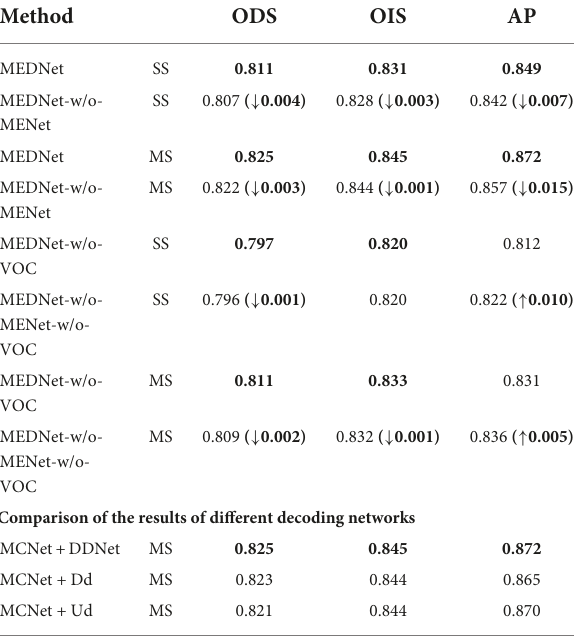
TABLE 2 Comparison of results of modulation encoding and decoding network (MEDNet) under different conditions.